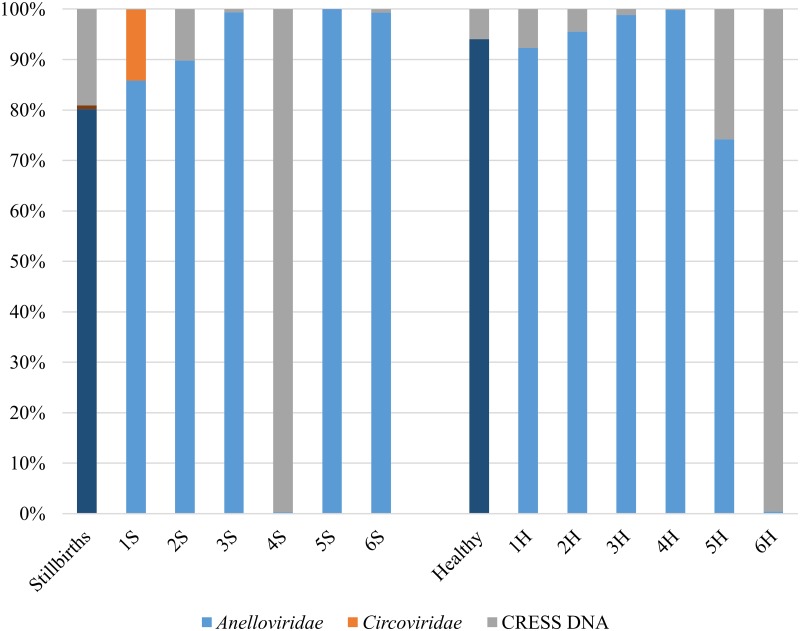
Distribution of sequence reads matching different eukaryotic viral families in each group.The number of reads corresponding to each family was normalized by the number of eukaryotic viral reads. Dark blue columns represent the average reads obtained in each of the groups. The numbers followed by a letter in parenthesis correspond to the identification of the pools analyzed in this study. Numbers correspond to each of the farms (1–6); letters S (stillbirth) or H (healthy) refer with the occurrence of stillbirths. Reads related of Circoviridae were identified in three pools: 1S, 3S and 3H.